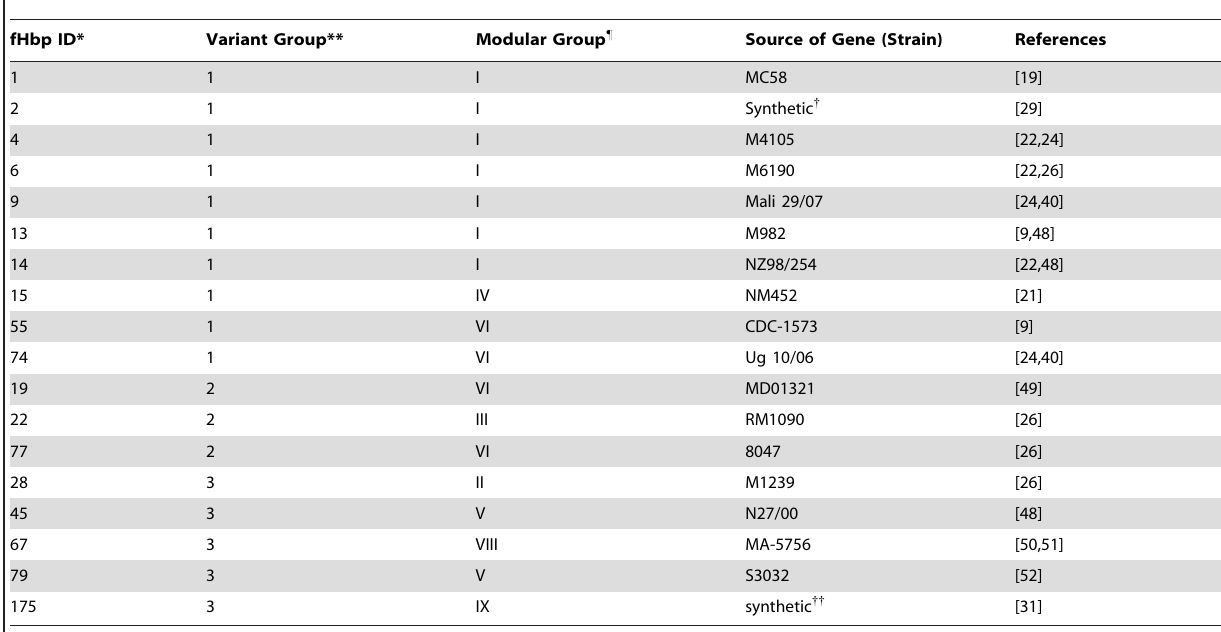
Table 1. Recombinant fHbp sequence variants tested for anti-fHbp mAb reactivity.